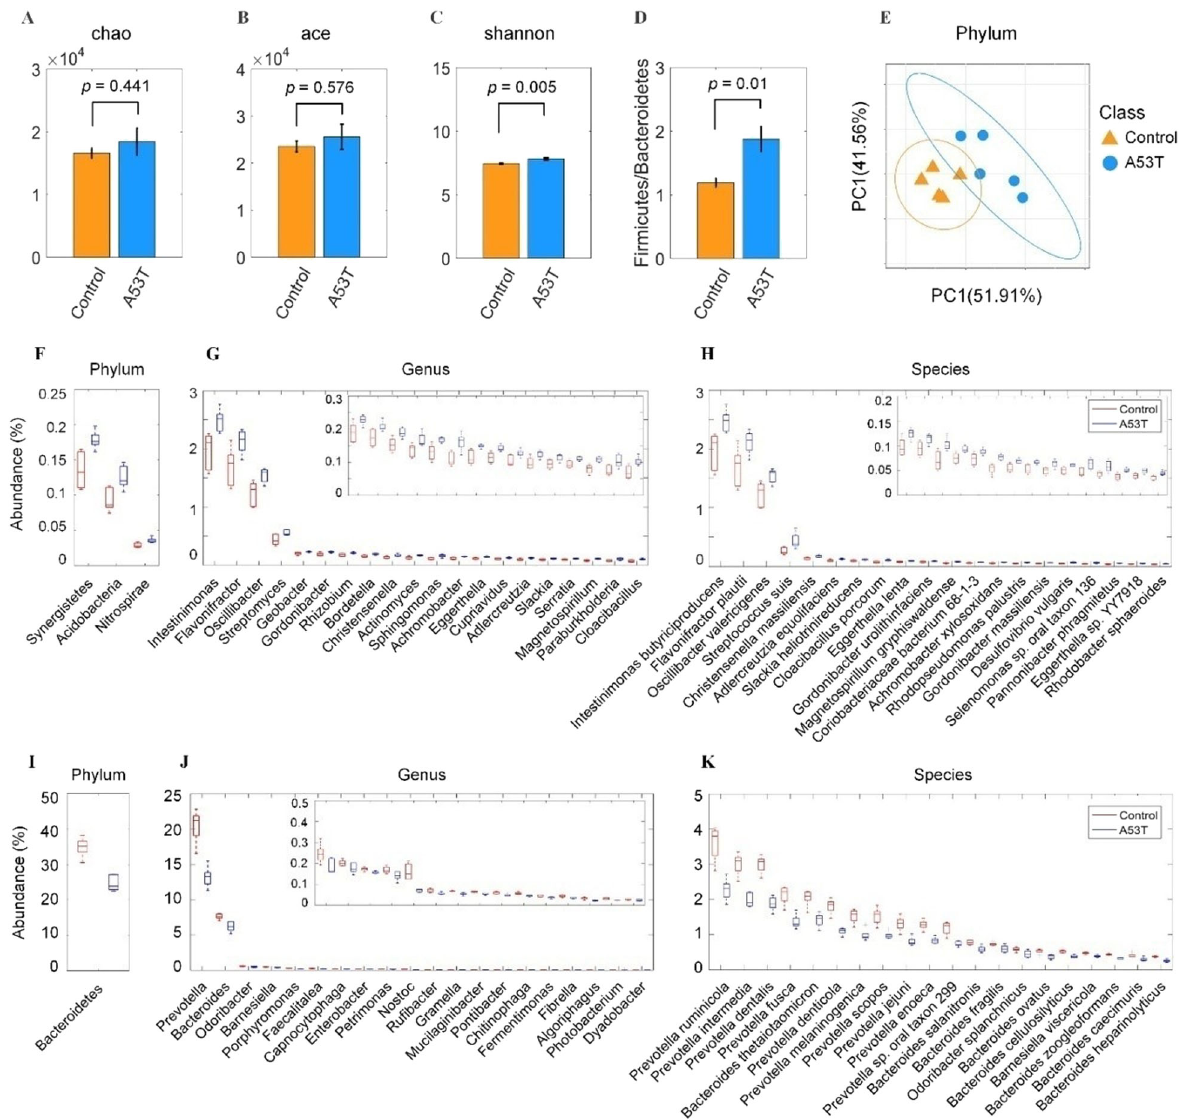
Fig. 1 Phylogenetic pro fi les of gut microbes in A53T transgenic monkeys. A – C α diversity including Chao index, Ace index, Shannon index. Shannon index signi fi cantly increased in the A53T transgenic group compared to the control group ( p < 0.005). D The ratio of Firmicutes to Bacteroidetes increased in the A53T transgenic group. E An obvious separation between the A53T transgenic group and the control group was observed by β diversity analysis. F , G , H The phylotypes signi fi cantly increased ( p < 0.05) in the A53T transgenic monkeys at the phylum, genus, species levels. I , J , K The phylotypes signi fi cantly decreased in the A53T transgenic monkeys at the phylum, genus, and species